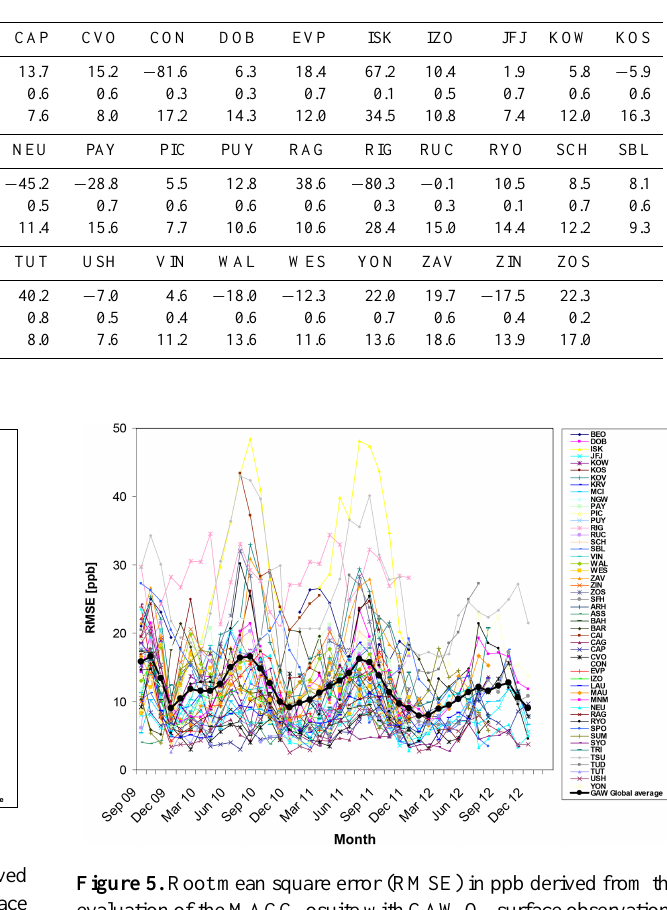
Table 4. Modified normalised mean bias (MNMB) [%], correlation coefficient ( R ), and root mean square error (RMSE) [ppb] derived from the evaluation of the MACC_osuite with Global Atmosphere Watch (GAW) O 3 surface observations during the period September 2009 to December 2012. The conventional station names are listed in Table 3.